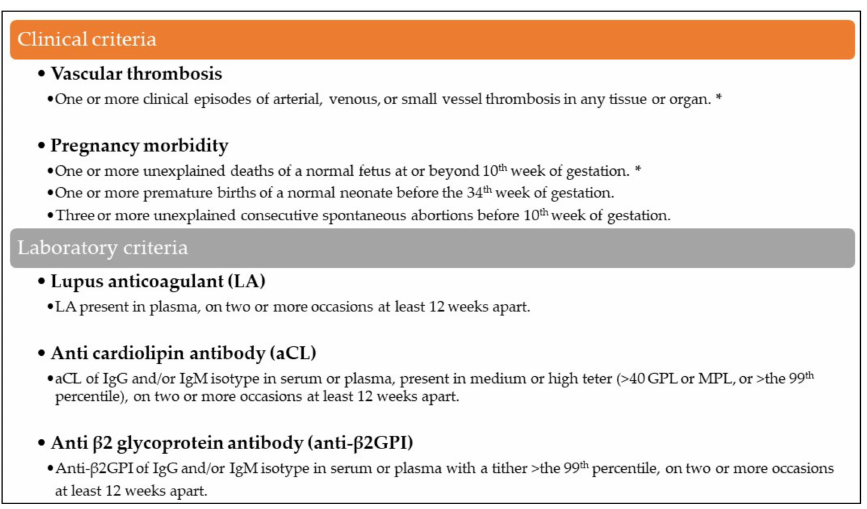
Figure 3. APS diagnosis criteria, updated at the Eleventh International Congress on Antiphospholipid Antibodies in Sydney in 2006. Antiphospholipid antibody syndrome (APS) is present if at least one of the clinical criteria and one of the laboratory criteria are met. Seronegative APS can be considered when a patient displays clinical features of APS with negative lab results. The clinical criteria that correspond the subject is marked